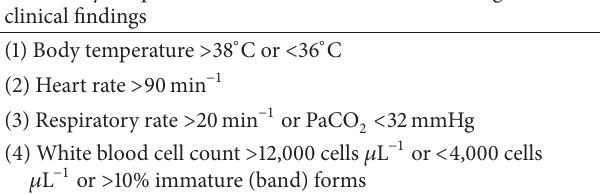
Table 1: Diagnostic criteria for the systemic inflammatory response syndrome